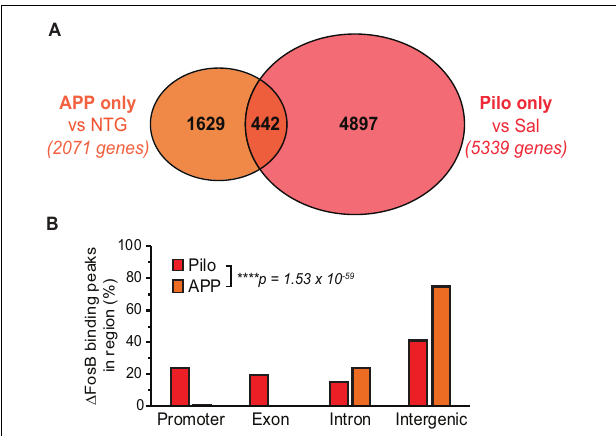
FIGURE 2 | Binding of (cid:49) FosB to target genes can depend on particular conditions within a disease context, but (cid:49) FosB can also bind to some targets independently of seizure etiology. (A) Venn diagram of the number of genes bound by (cid:49) FosB only in APP mice (relative to NTG mice), and those bound only in Pilo mice (relative to Sal mice). (B) Genomic distribution of (cid:49) FosB binding peaks in the subset of 442 target genes common to APP and Pilo mice. **** p = 1.53 × 10 - 59 , Chi-square